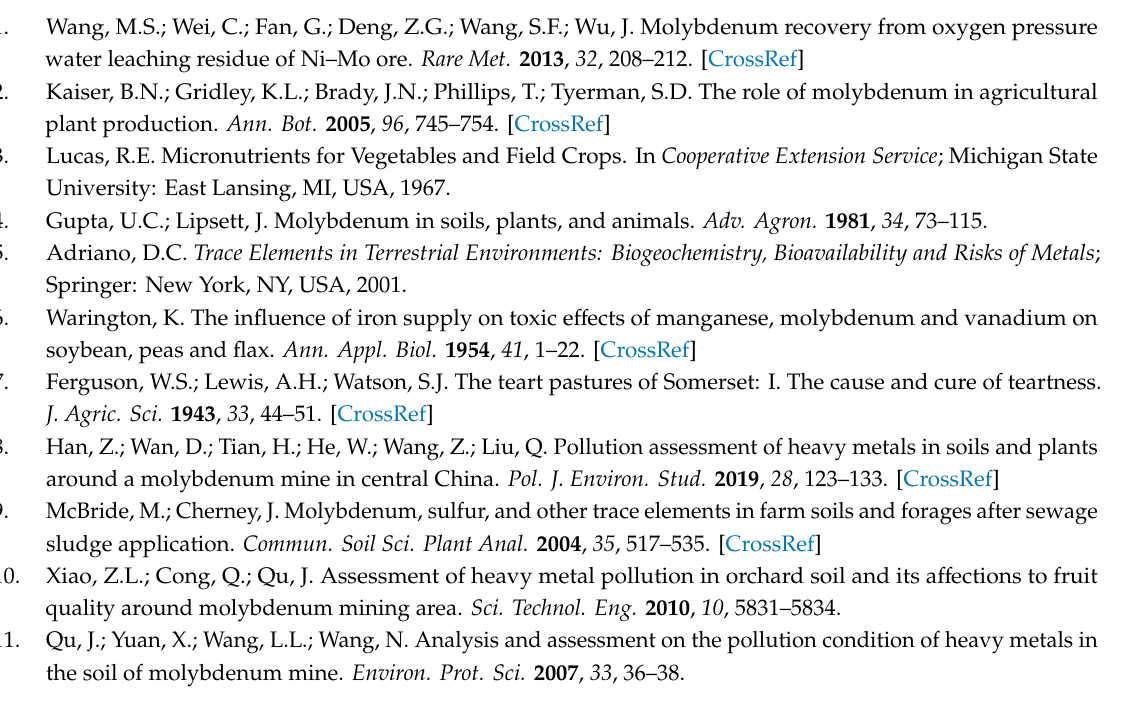
Table S1. Pearson correlation between Mo concentrations in soil and Mo concentrations / uptake in plant